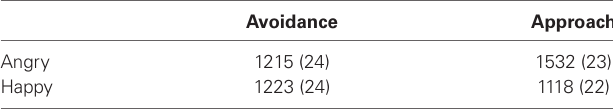
Table 2 | Mean reaction times on the emotional decision making task . Avoidance